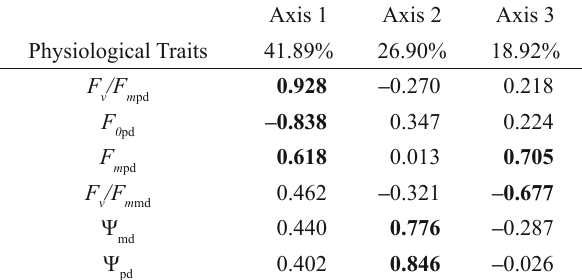
Eigen vector scores from a PCA of three axes obtained from a matrix of six traits and six species in two seasons. The six ), traits measured were midday leaf water potential ( Ψ md predawn leaf water potential ( Ψ ), potential quantum yield pd of photosystem II at midday ( F /F ), potential quantum v m md yield of photosystem II at predawn ( F /F ), minimal v m pd fl uorescence yield ( F ) and maximal fl uorescence yield 0 pd ( F ). Percentage values indicate the percentage of m pd variation accounted for by each axis. Bold values indicate the highest values for each